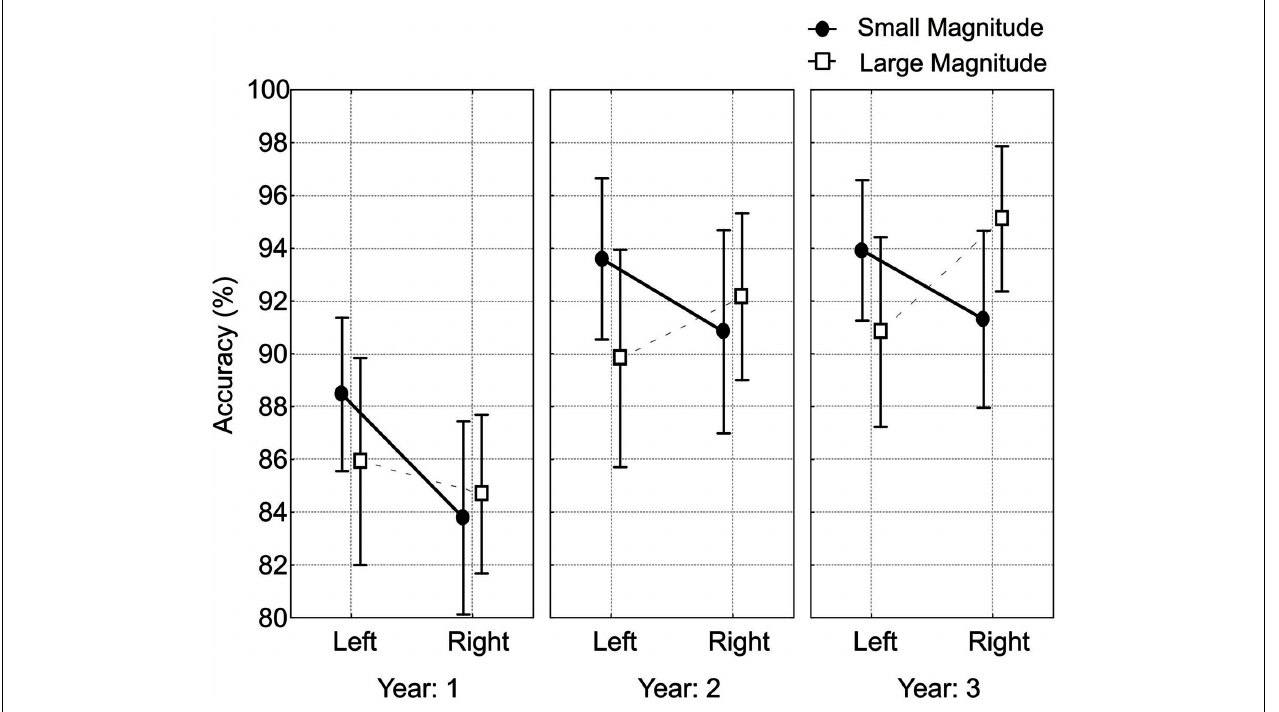
FIGURE 2 |The SNARC effect (Magnitude × Response Side) for accuracy; the effect was significant inYear 3. The error bars indicate 95% confidence intervals.